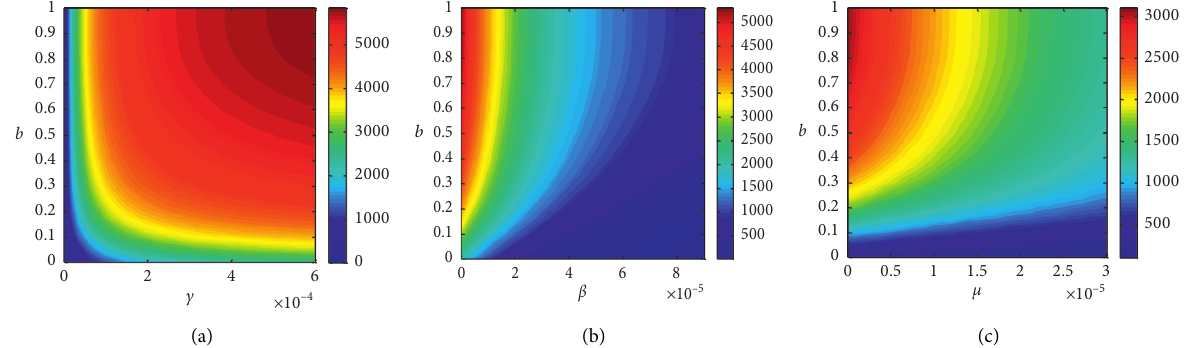
Figure 7: Number of RI nodes with changing b versus c , β , and μ , respectively. Q � 0.9, T � 20000, and other settings are the same as the default